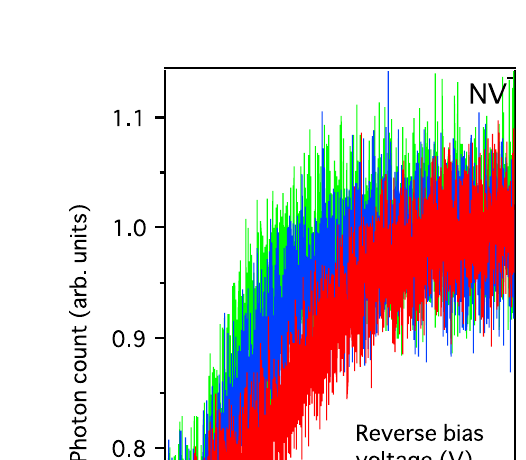
FIG. 9. Change in the total transition